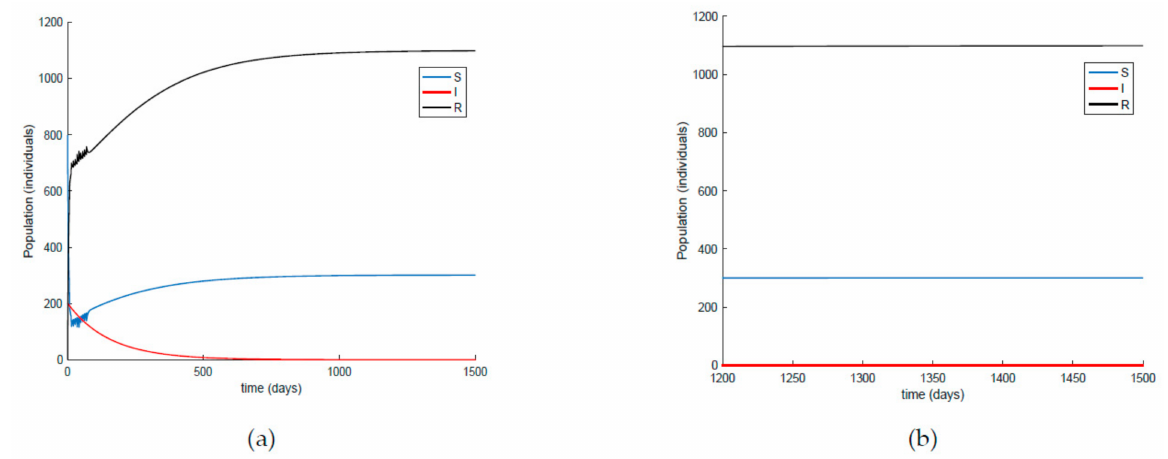
Figure 22. ( a ) Extended simulation time in Figure 19 and ( b ) zoomed image of the final time period for the susceptible and recovered individuals with limited-in-time impulsive vaccination